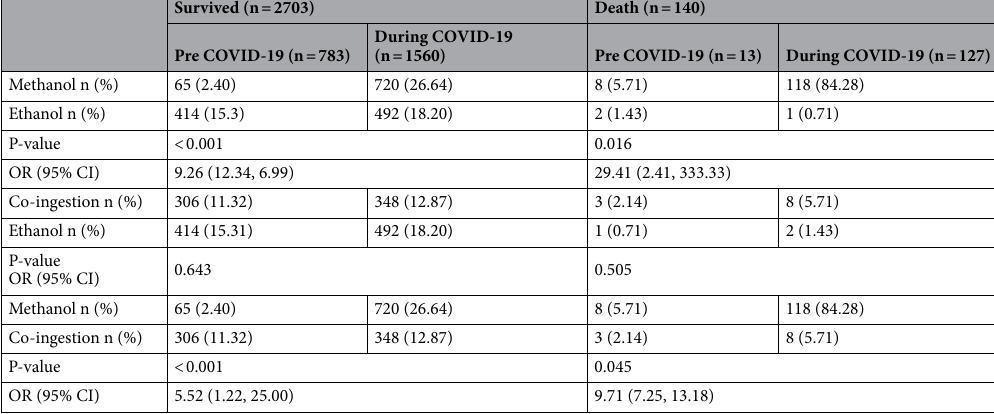
Table 2. Comparison of different groups of alcoholic ingestions 1 year before and after COVID-19 (n = 2483).